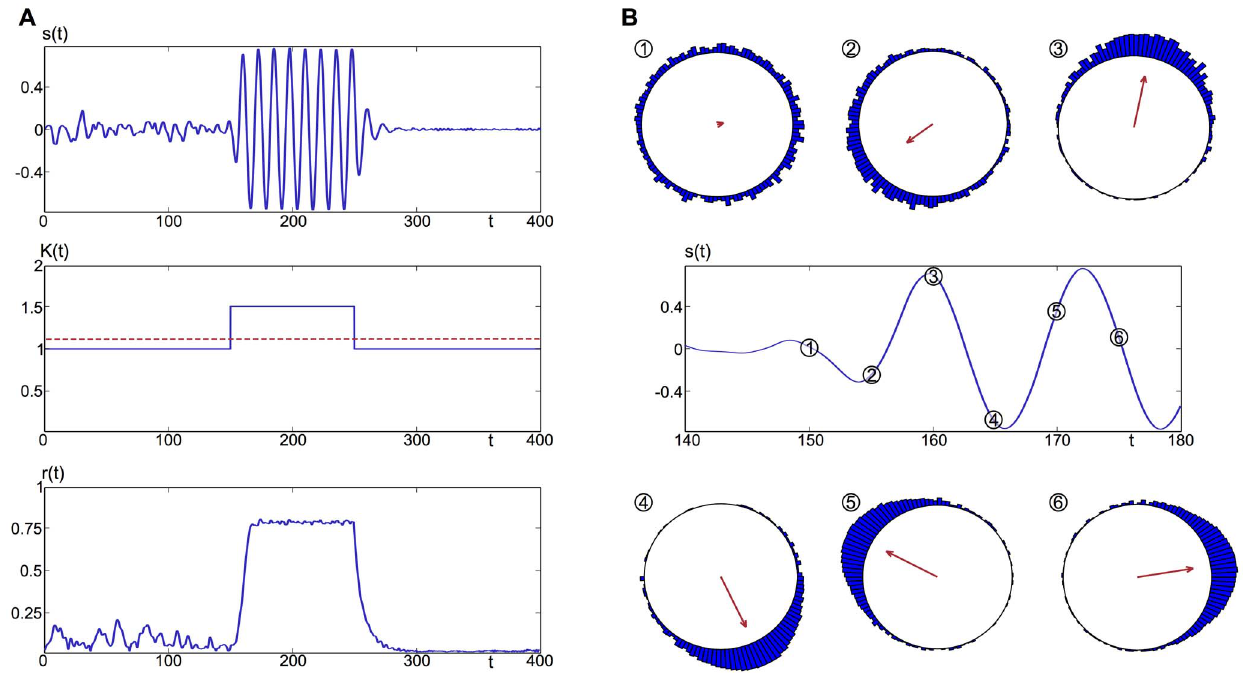
cos( h i ( t )) is irregular i